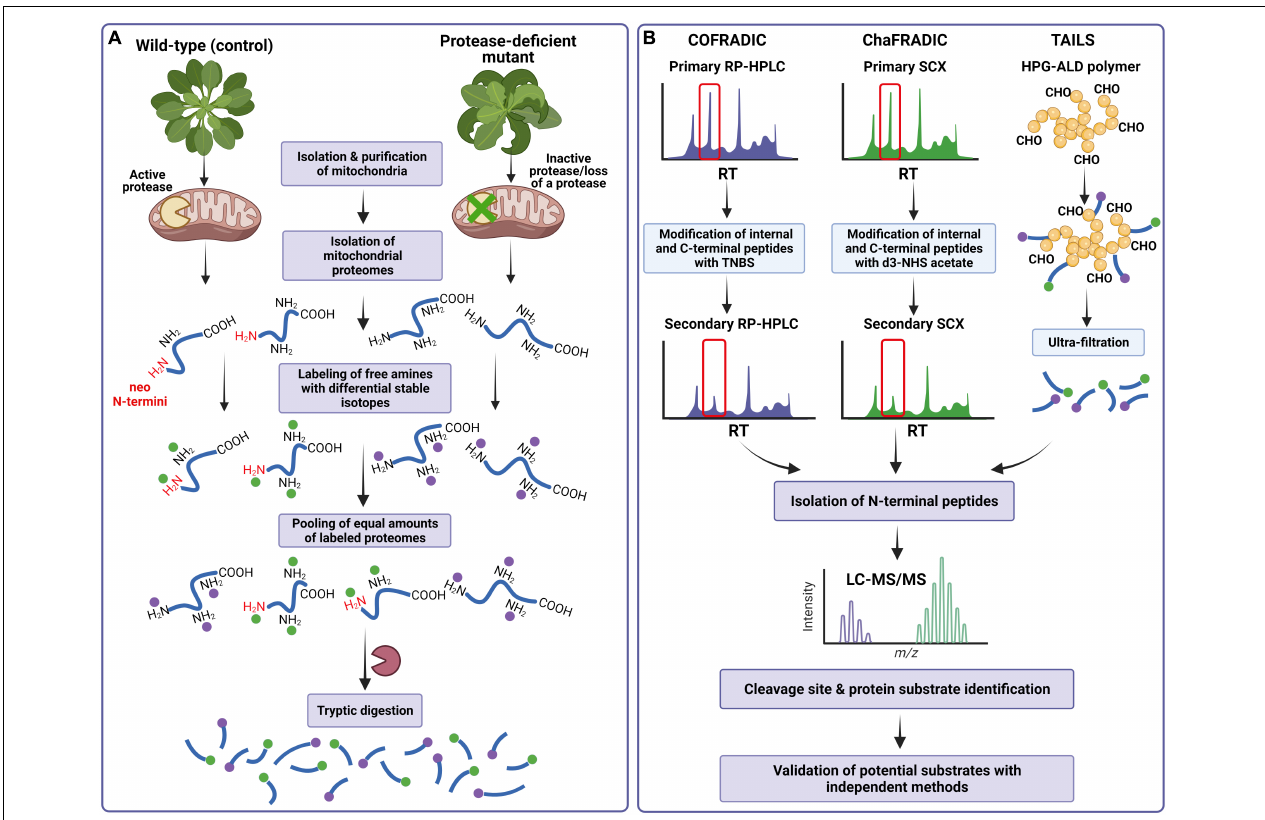
FIGURE 3 | Scheme of the N-terminomics workflow for identifying a protease cleavage site and processing substrates using COFRADIC, ChaFRADIC, and TAILS as negative selection approaches for isolating N-terminal peptides in mitochondrial proteome studies. (A) Mitochondrial proteins isolated from the control and protease-deficient plants (containing protein neo-N- and native N-termini, respectively) are subjected to labeling all primary ( α and ε ) amines using stable differential isotopes to mass-tag native and neo-N-terminal peptides. Samples are pooled and digested by trypsin together. As a result, new primary α -amines at the N-termini of internal and C-terminal peptides are generated. (B) In COFRADIC and ChaFRADIC, the obtained peptides undergo the first separation by reversed-phase high-performance liquid chromatography (RP-HPLC) (COFRADIC) or by strong cation exchange (SCX) chromatography (ChaFRADIC). All collected peptides are modified with TNBS (in COFRADIC) or d3-NHS (in ChaFRADIC) to alter the retention time of internal and C-terminal peptides. The peptides are then subjected to the second identical chromatography step, in which only previously labeled N-terminal peptides are collected. In the case of TAILS, tryptic peptides are incubated with a polymer HPG-ALD. In this reaction, only internal peptides will bind to the polymer. The polymer-bound internal peptides are removed by centrifugation, while the N-terminal peptides are further recovered by filtration. In each type of experiment, the N-terminal peptides are analyzed by LC-MS/MS, which provides the protease cleavage site and identifies processing protein substrates. COFRADIC, combined fractional diagonal chromatography; ChaFRADIC, charge-based fractional diagonal chromatography; TAILS, terminal amine isotope labeling of substrates; TNBS, 2,4,6-trinitrobenzenesulfonic acid; d3-NHS, trideutero N -hydroxysuccinimide; HPG-ALD, high molecular weight polyglycerol aldehyde polymer; LC-MS/MS, liquid chromatography-tandem mass spectrometry. Details regarding specific methodologies are described in the main text. Based on Demir et al. (2018). Created with